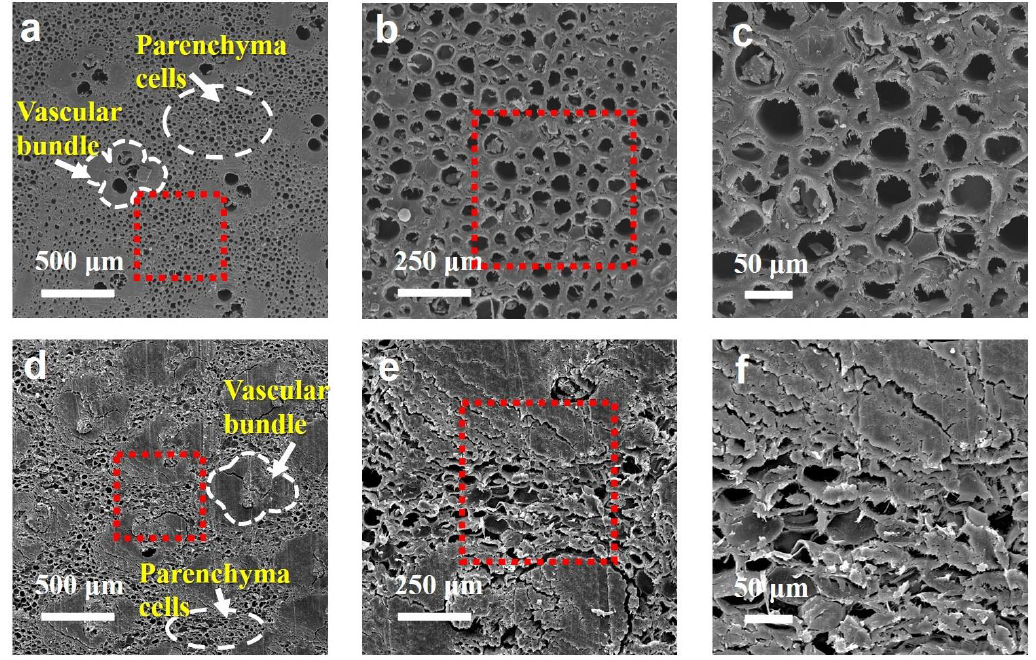
Figure 3. SEM images of ( a – c ) untreated bamboo and ( d – f ) FBB.